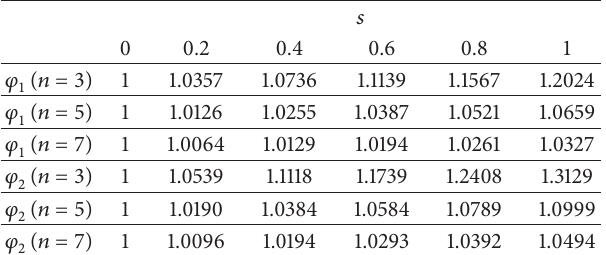
Figure 7: Relationship between ratio 𝜑 2 and dimensionless param- eter 𝑠 for different mode number 𝑛 . Table 3: Steady-state vibration amplitudes ratios 𝜑 1 and 𝜑 2 for different mode shape number 𝑛 .